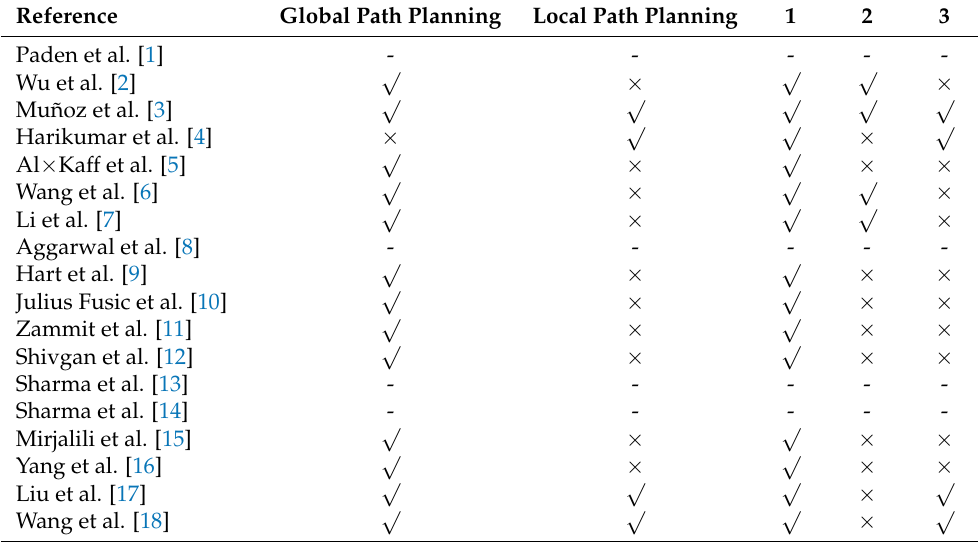
Table 1. Relative comparison of the existing path planning